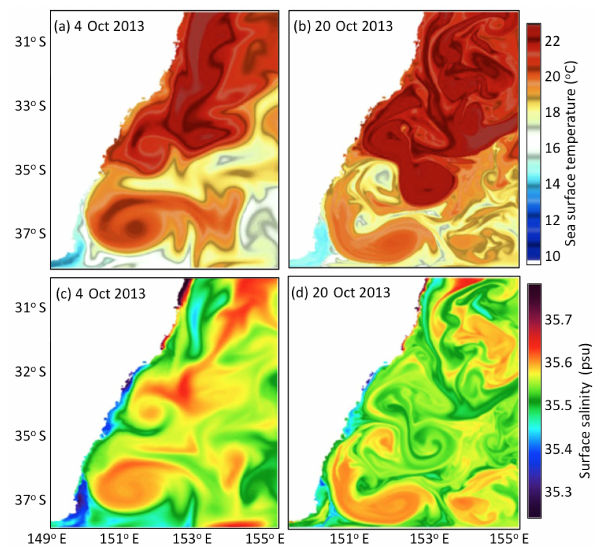
Figure 8. Snapshots of (a–b) sea surface temperature and (c–d) sur- face salinity for the (a, c) initial conditions, interpolated from a 0.1 ◦ resolution model (OceanMAPS), and (b, d) the model fields after 16 days of evolution by a 2km resolution model.